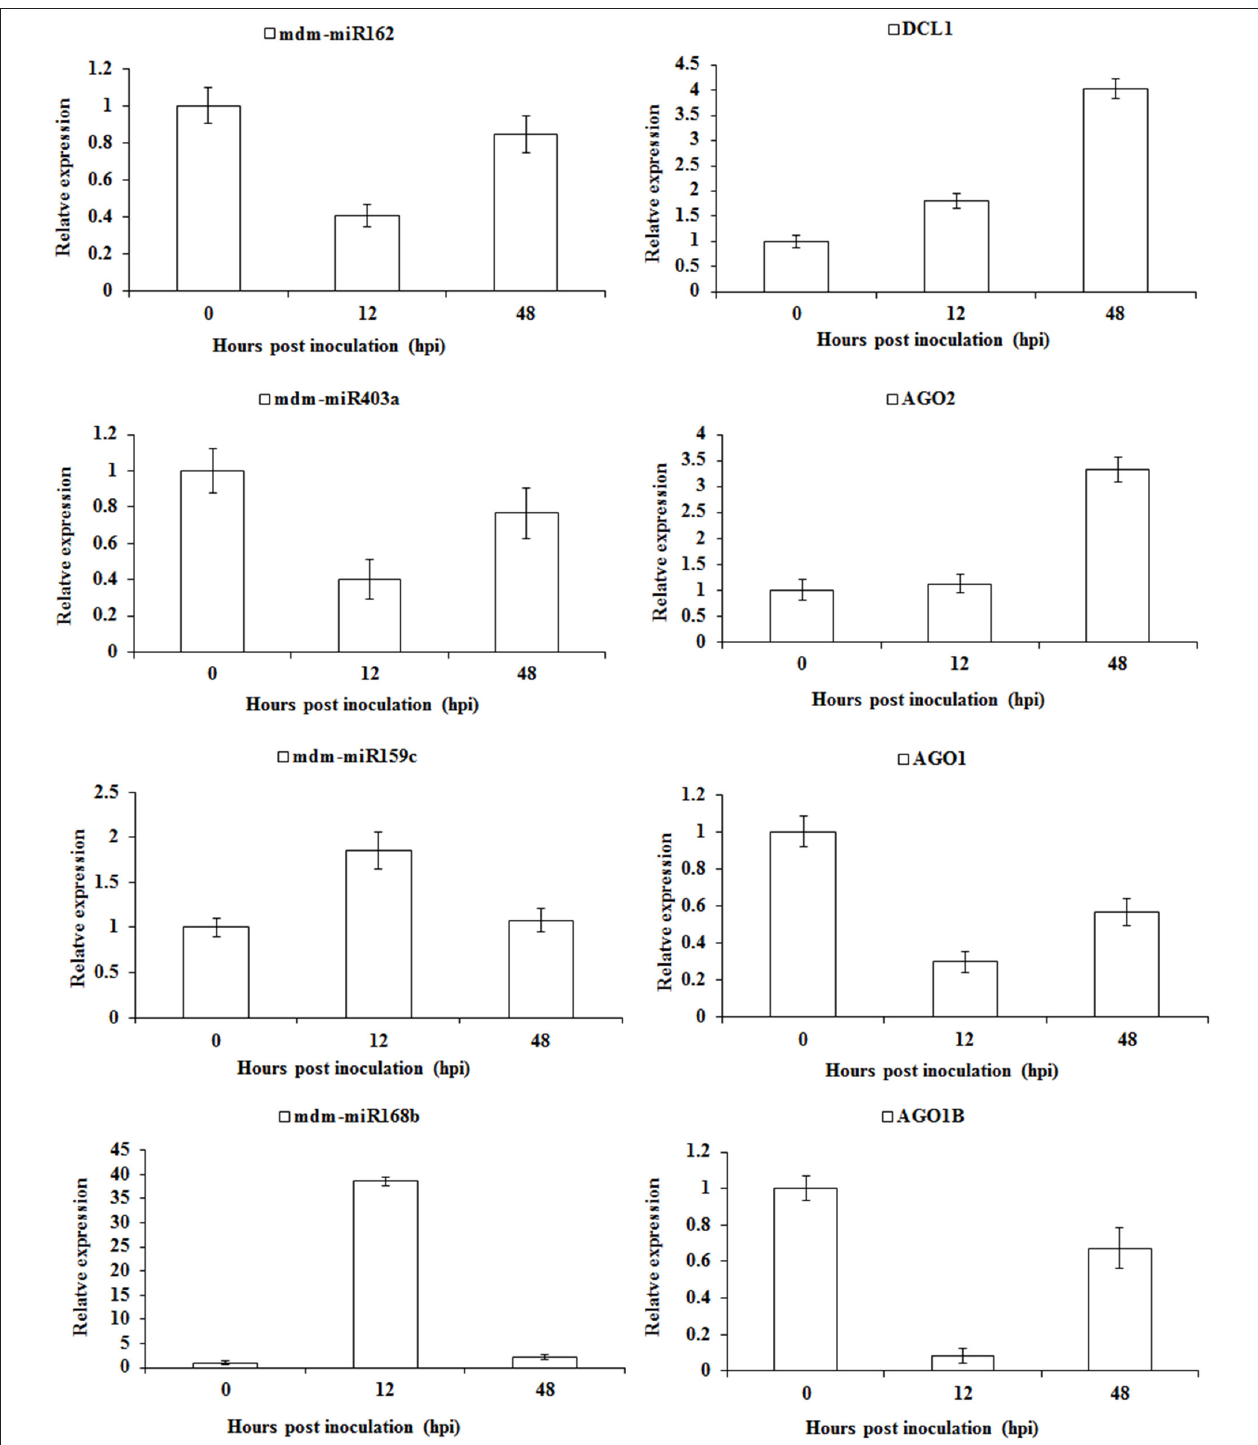
FIGURE 8 | Relative transcription levels of miRNAs and corresponding target genes involved in the feedback regulation of sRNAs pathway in apple twig- Vm interaction. One DCL1, one AGO2, and two AGO1 transcripts were identified to be the target genes of mdm-miR162, mdm-miR403a, mdm-miR159c, and mdm-miR168b. Their transcript accumulation in apple twig bark tissues after challenge with V. mali was analyzed (12 and 48 hpi). The data were normalized to the inner reference gene apple translation elongation factor 1 alpha-subunit (EF-1a, Gene ID/Accession no. DQ341381). The mean value was calculated from three independent biological replicates. The relative expression level was analyzed as the fold-change of the mock-inoculated plants at that time point using the comparative 2 − 11 CT method.